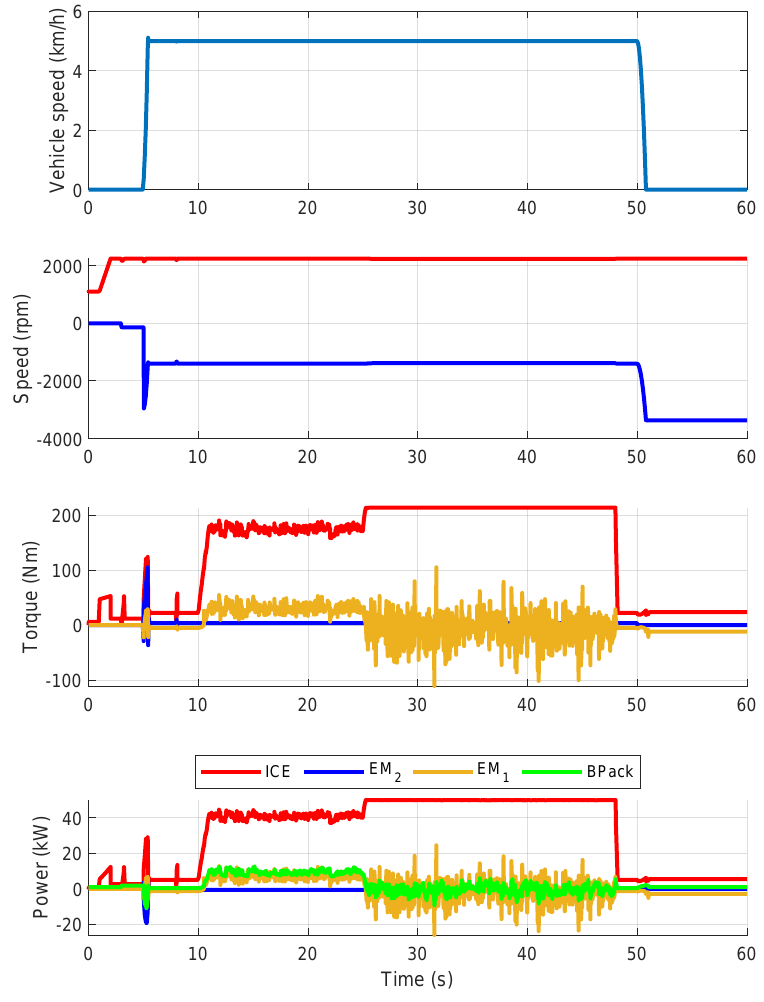
Figure 10. HeCVT rotary harrow